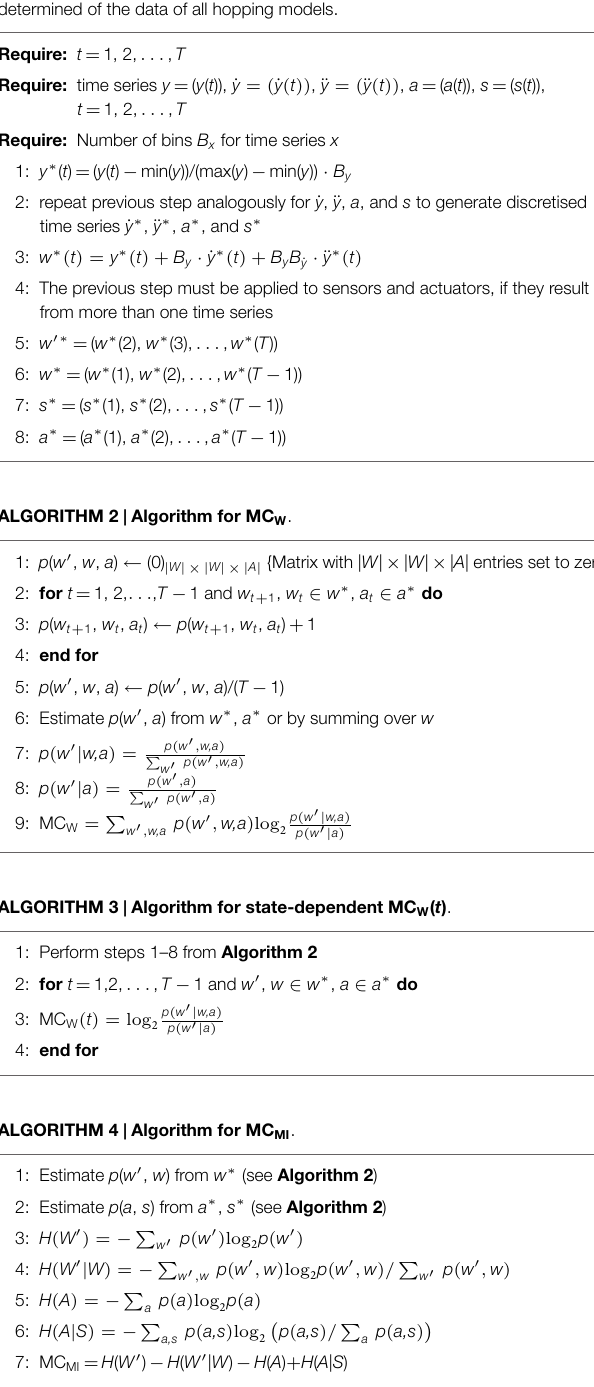
ALGORITHM1 | Discretisationofthedata .Thispartisthesameforallmeasures, depending on which time series are required. The minimum and maximum were determined of the data of all hopping models.